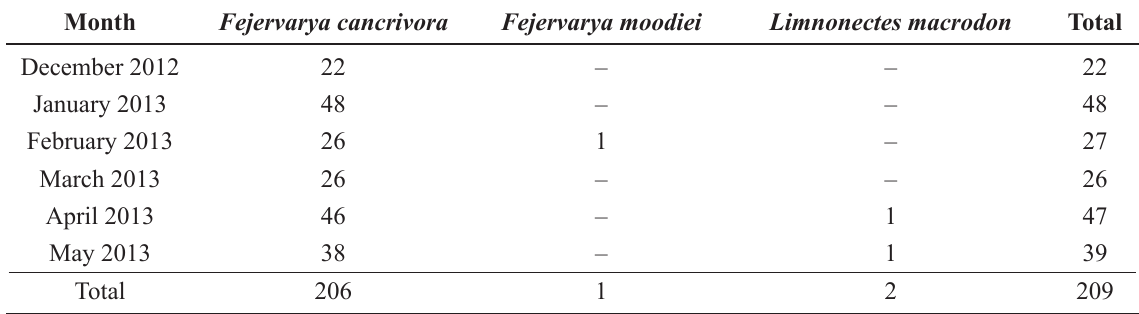
Table 1. Species identification recovered from a Blast in GenBank (16S gene) of the 209 specimens of frogs bought in French supermarkets from December 2012 to May 2013 and identified on the label as “ Rana macrodon from